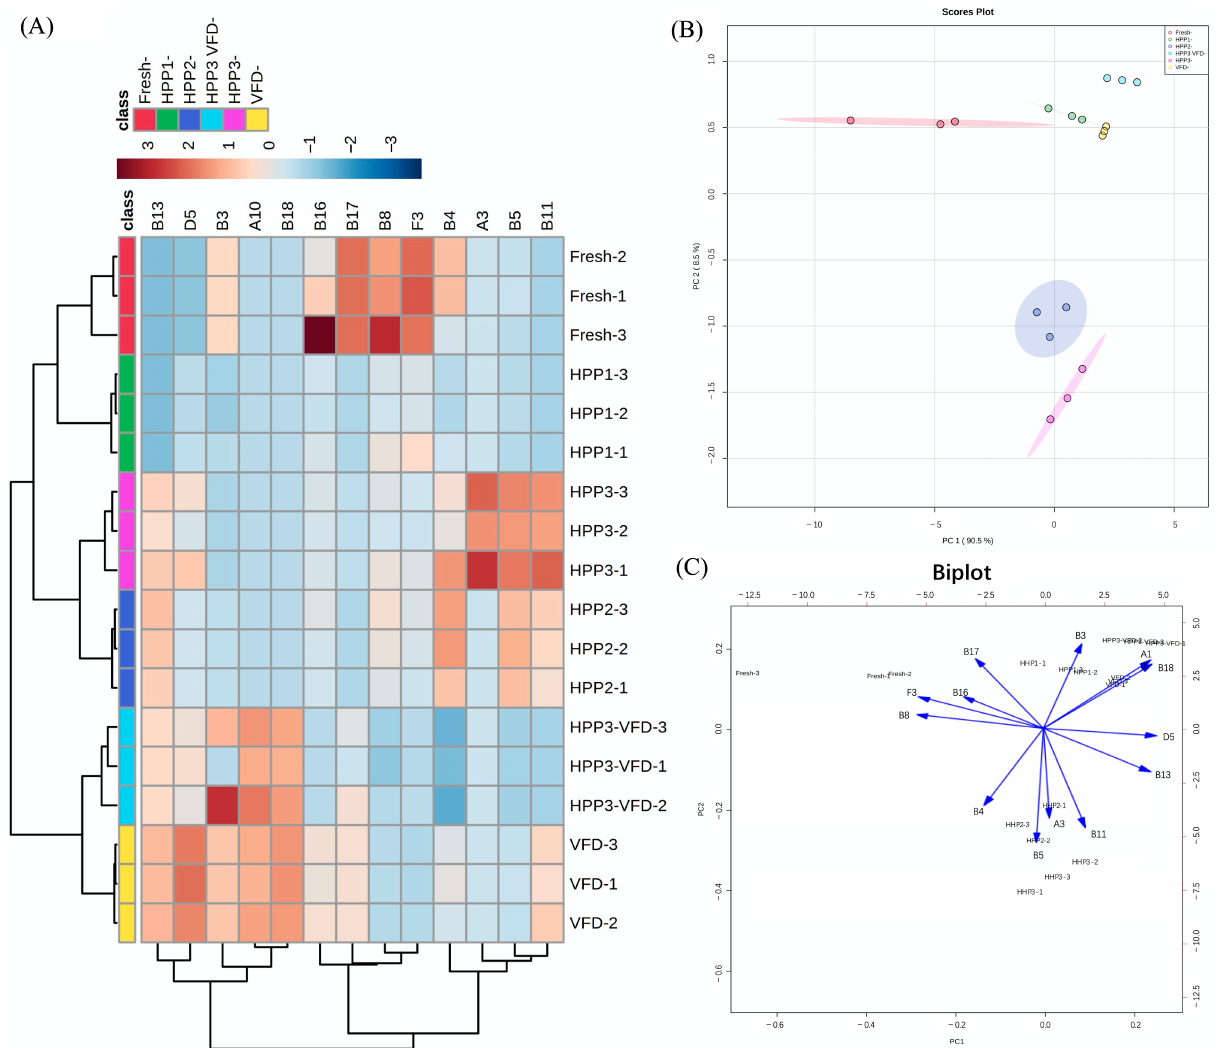
Figure 5. ( A ) Heat map and hierarchical clustering of 13 major aroma-active compounds in different processed blended juices and rehydrated juices. ( B ) Score plots and ( C ) biplots of PCA on the expressions of the major aroma-active com- pounds.